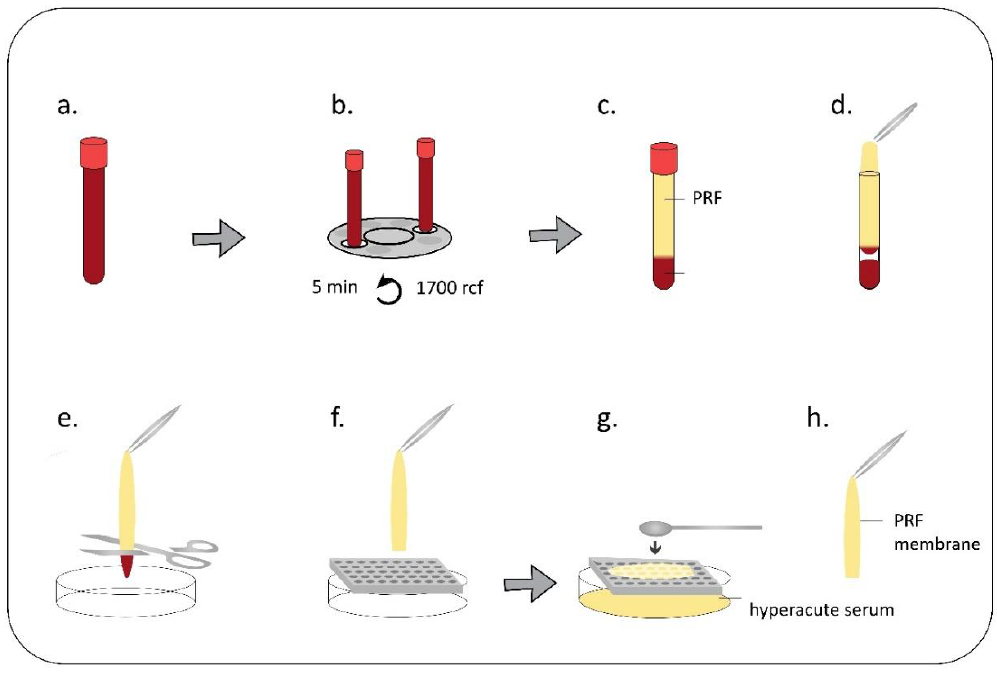
Figure 1. PRF membrane preparation by glass blood drawing tube. 8 mL venous blood was taken by venipuncture from healthy volunteers into glass tube ( a ) and it was immediately centrifuged (1700 rcf, 5 min) ( b ). After centrifugation two layers were observed in the tubes. The top layer was the platelet-rich fibrin clot, the base layer was the red blood cells ( c ). The PRF was removed by sterile forceps in a laminar flow tissue culture hood ( d ), red blood cells at the bottom of the fibrin clot were cut away ( e ) and the clot was placed onto a sterile grid ( f ). The hyperacute serum was squeezed out from the PRF clot by sterile spatule ( g ). The remaining film was the PRF membrane ( h ). (Figure 1, Figure S1A).